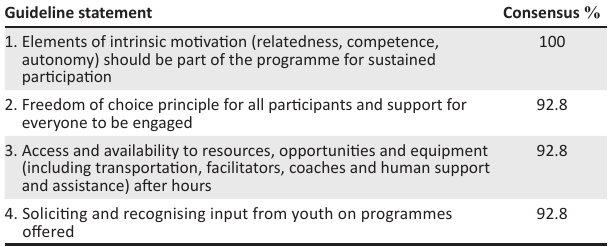
TABLE 3: Guidelines for an out-of-school approach to leisure education programmes.